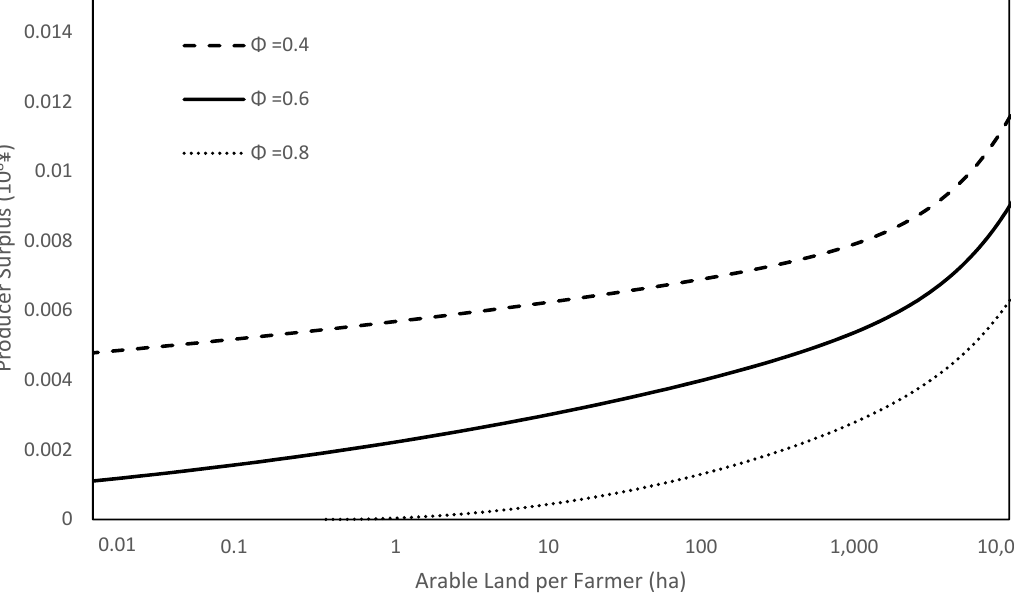
Figure 6. Relation of ALPF to producer surplus. Note: Producer surplus is calculated from the equilibrium price P mar and the supply curve, Equation (14) in Section